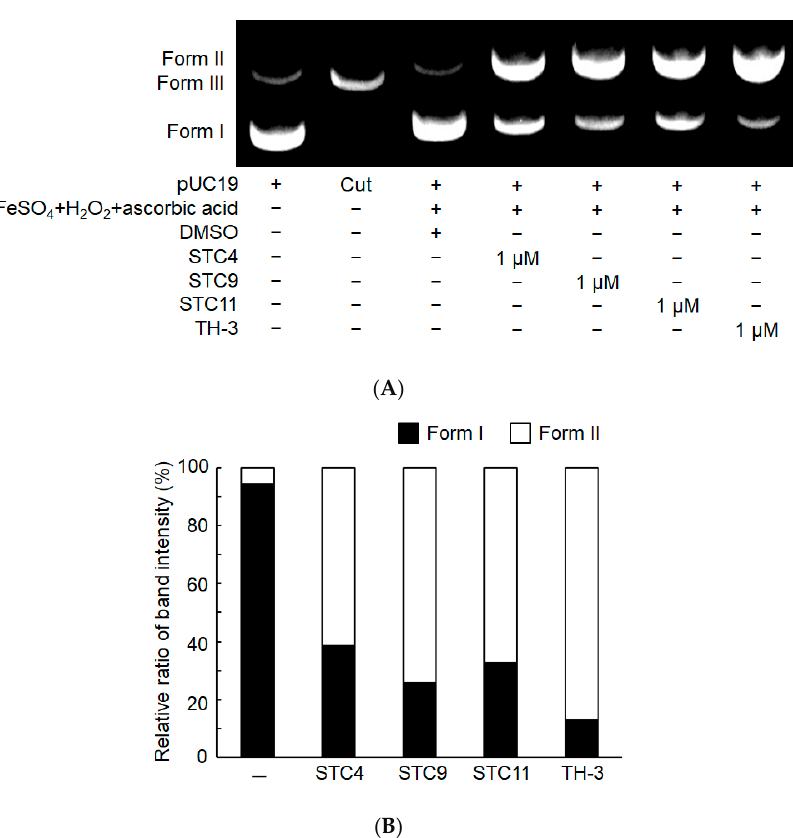
Figure 3. The inhibitory effects of selected compounds on DNA cleavage in the presence and absence of FeSO 4 , H 2 O 2 , and ascorbic acid. ( A ) Form I (supercoil), form II (single strand break), and form III (double strand break) bands after electrophoresis. The Form I band is the lower and the Form II band is the upper portion. The pUC19 enzyme cut (by Eco R I) generates form III with mid mobility (the second lane from the left). ( B ) Relative intensity of form I and form II bands.